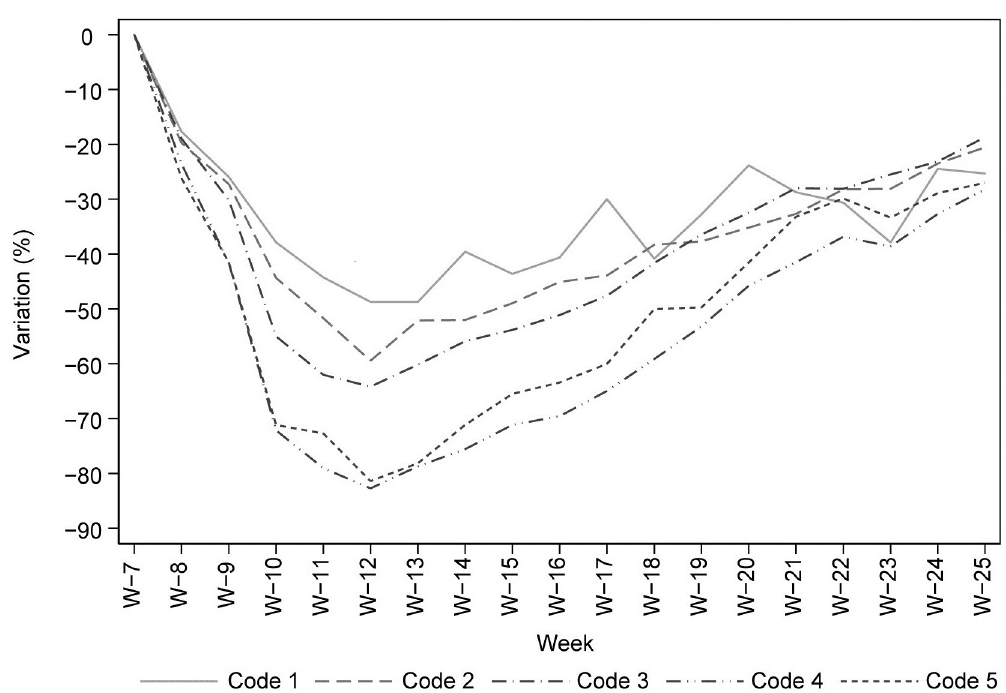
Fig 5. Percentage changes in emergency department admissions by triage category (Year 2020), reference period: Weekly average admissions registered in the pre-pandemic period (week 1 to 6 of 2020).